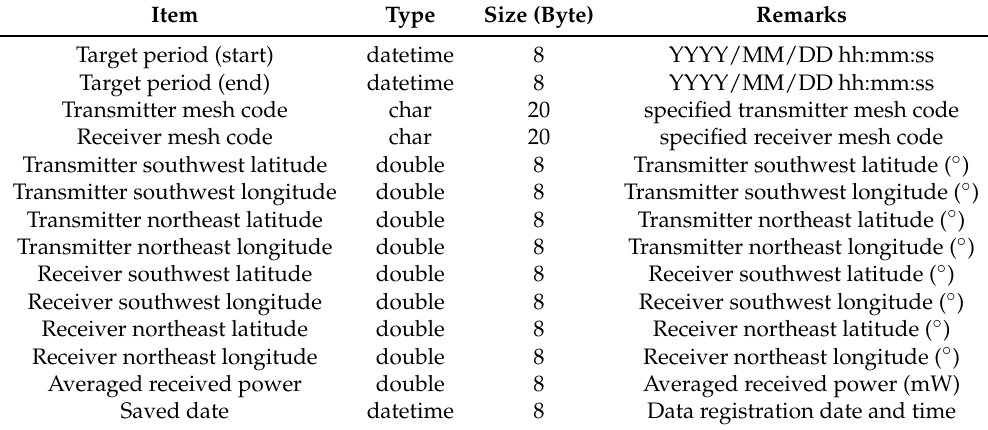
Table 5. Statistical data.